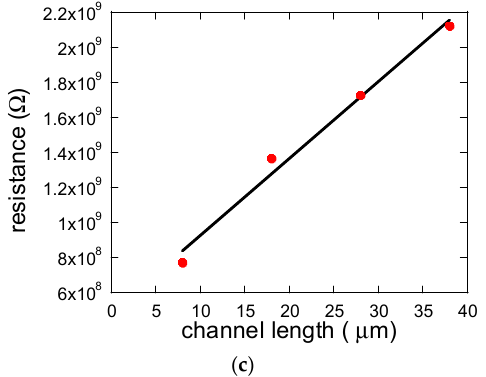
Figure 2. ( a ) Schematic diagram of a ZnO/PbSe/ZnO test platform device. ZnO (70 nm) source and drain electrodes and 3 nm PbSe quantum dot (QD) films (90 nm) are patterned onto a 200 nm thick SiO 2 substrate. The channel length between ZnO source and drain electrodes varies between ~6 and ~40 μ m. The channel width is 3 mm. ( b ) Current–voltage curves at different channel lengths of 8, 18, 28 and 38 μ m at 293 K. ( c ) Plot of total resistance as a function of channel length for calculation of contact and channel sheet resistances at 293 K.